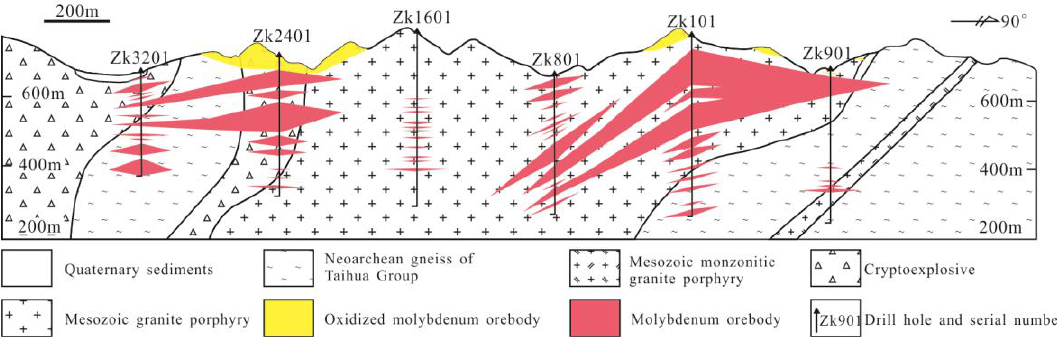
Figure 3. Geological section along No. I exploration line of Leimengou Mo deposit (after Chen et al., 2011 [8]).